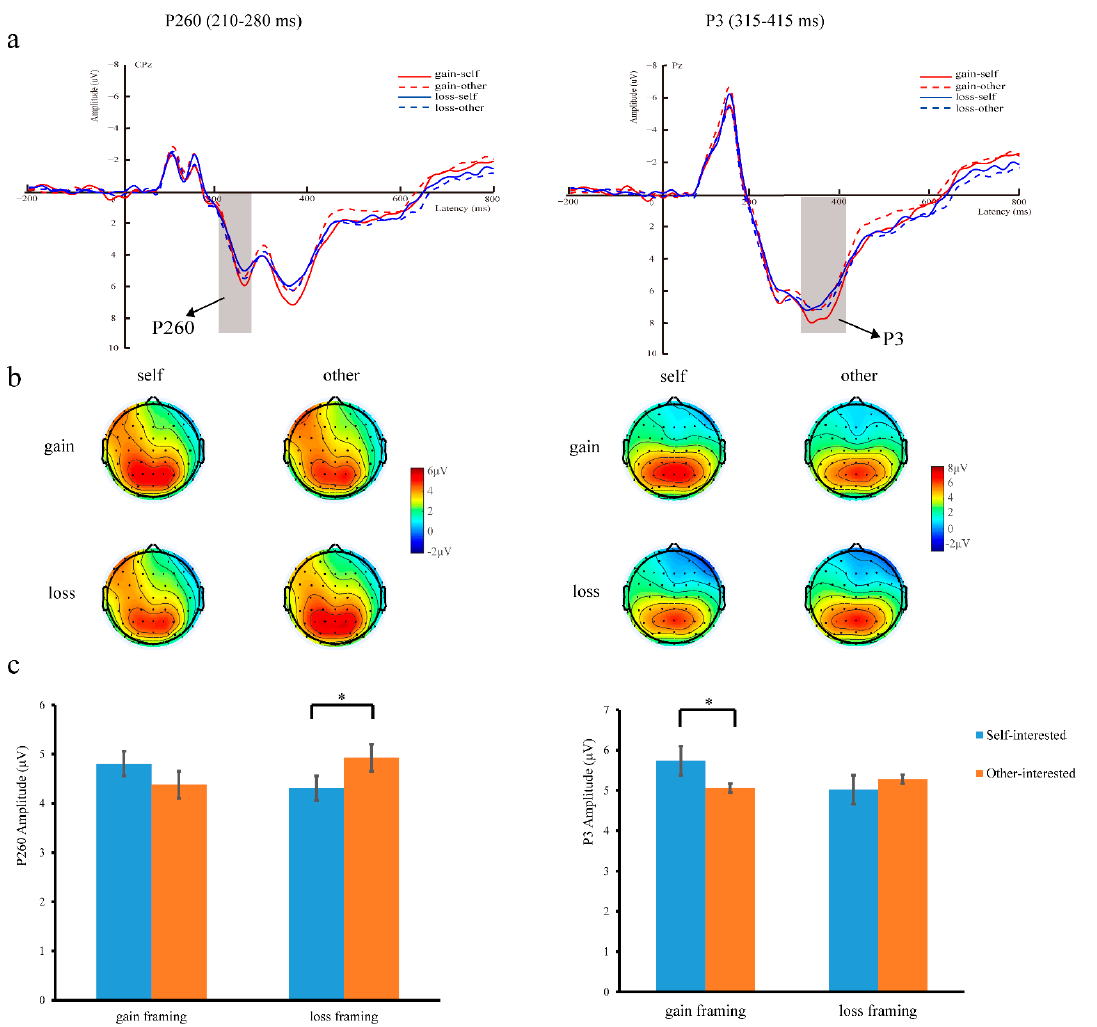
Figure 5. ( a ) Grand-average ERP waveforms at CPz (left) and Pz (right). The grey bars highlight the time window of P260 (210–280 ms) (left) and P3 (315–415 ms) (right); ( b ) Topographies’ voltage distribution of P260 (left) and P3 (right) for each condition; ( c ) The bar graphs of mean P260 and P3 values for each condition. * p < 0.05. Self-interested: self-interested green products, Other-interested: other-interested green products. Gain-self: gain framing-self-interested green products, Loss-self: loss framing-self-interested green products, Gain-other: gain framing-other-interested green products, Loss-other: loss framing-other-interested green